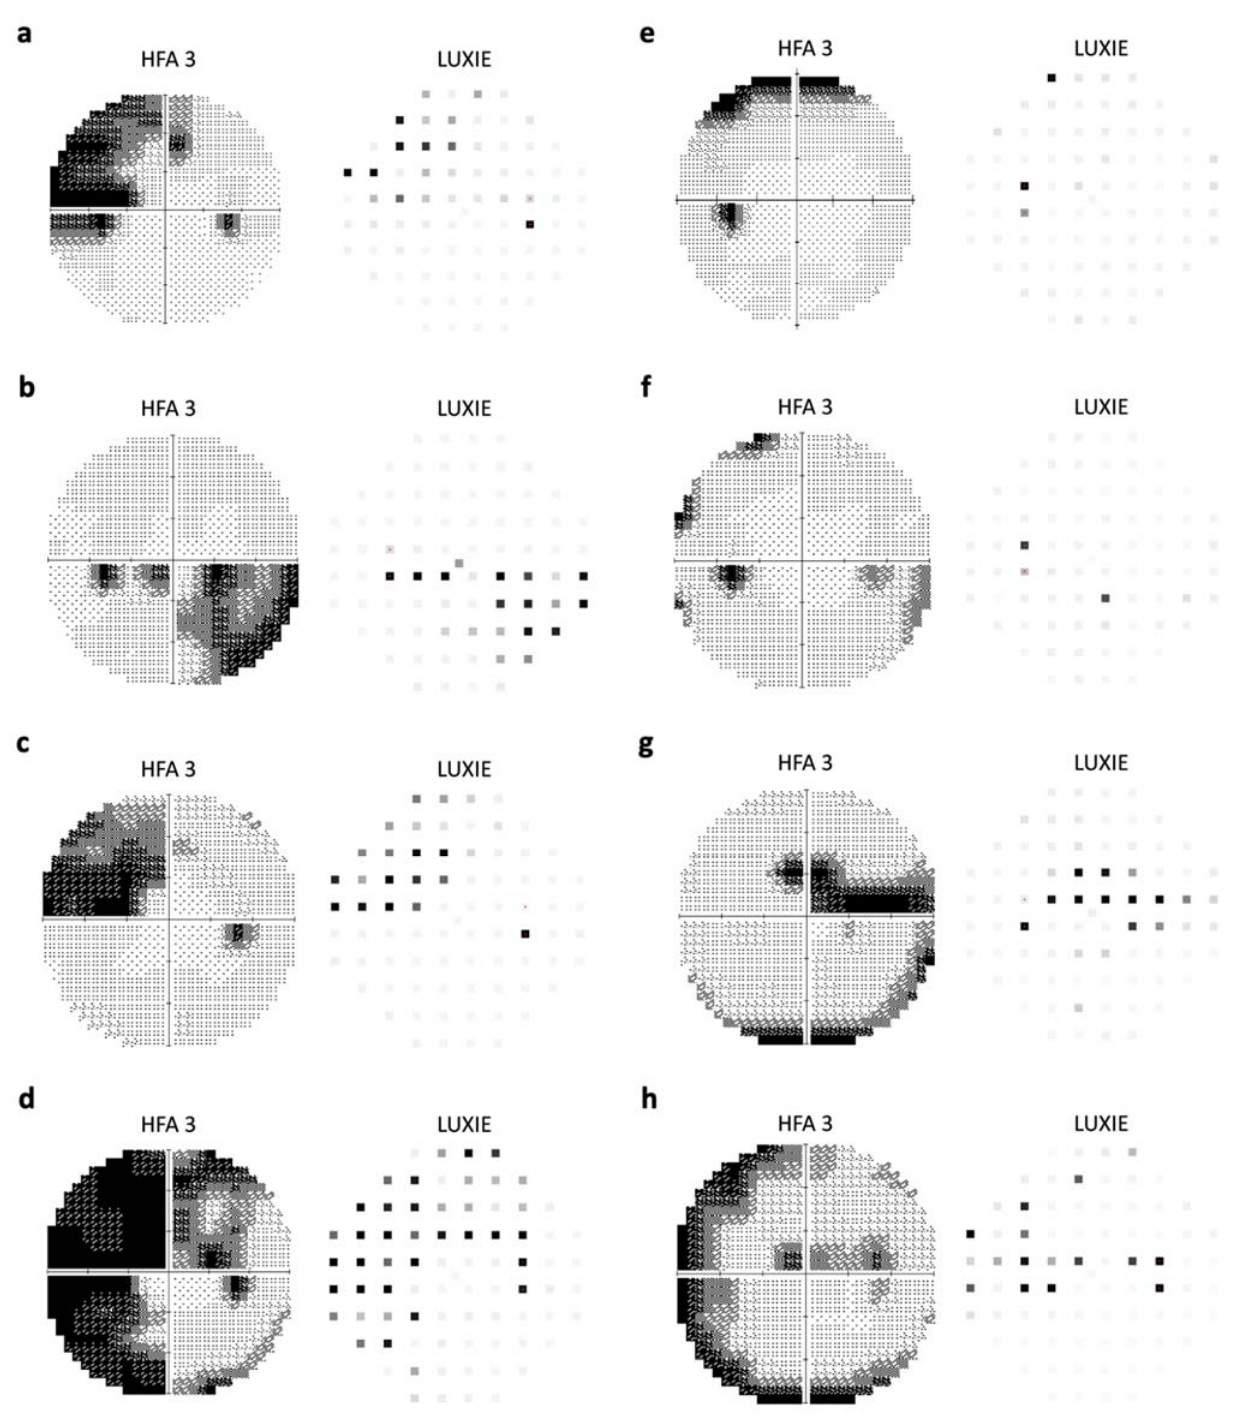
Figure 5. Examples of visual field grayscale maps generated by Humphrey Field Analyzer 3 (HFA3) and LUXIE. ( a ) Superonasal visual field defect. ( b ) Inferonasal visual field defect. ( c ) Superonasal visual field defect. ( d ) Superior arcuate scotoma and inferior nasal step. ( e ) Superior rim defect on HFA3. ( f ) Inferior nasal step; temporal rim defect on HFA3. ( g ) Superior arcuate scotoma; inferior rim defect on HFA3. ( h ) Superior arcuate scotoma; rim defect on HFA3.